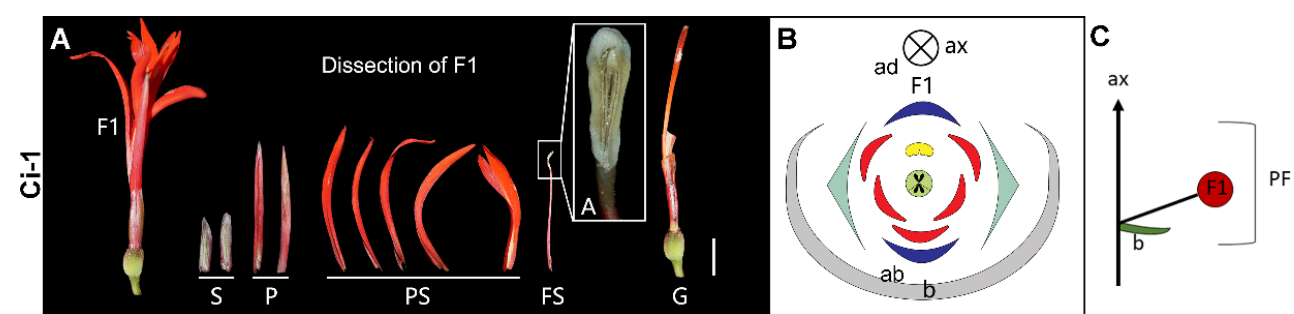
Figure 4. Single flower. ( A ) Photograph and ( B ) diagram of the partial inflorescence of Ci-1. ( C ) Longitudinal scheme of the lateral single flower. Bar = 1 cm.